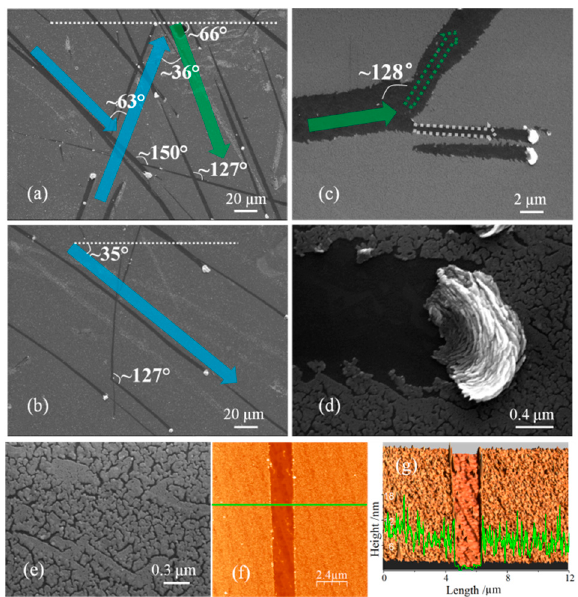
Figure 1. ( a , b ) macro view of Ag trenches after UHV annealing. ( c ) swerved and branched particle due to the defective point. ( d ) the details of Ag trench heads. ( e ) surface morphology of Ag thin film on EG without sliding trenches. ( f ) AFM image of trench after the sliding of Ag particles. ( g ) corresponding 3D image. The scale bars are marked in each image.